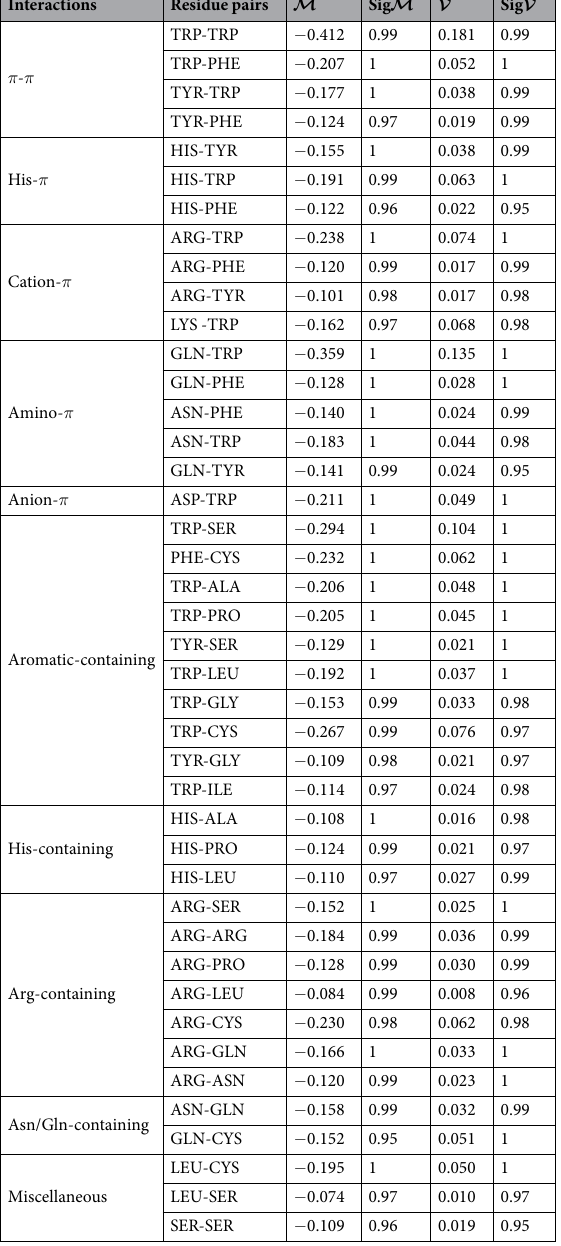
Table 1. Insolubilizing residue-residue interactions, defined by  < 0 and the strict significance criteria requiring both  | | and  values to be higher than 95% of the equivalent quantities computed from randomly shuffled datasets (Sig  and Sig ≥ . 0 95 